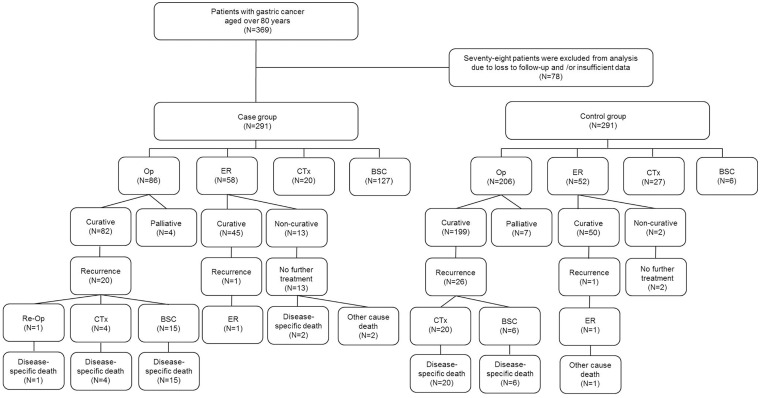
Flow chart of patients included in this study.A total of 291 patients aged over 80 years were included, and another 291 patients aged 80 years or younger were randomly selected as a control group. Op, operation; ER, endoscopic resection; CTx, chemotherapy; BSC, best supportive care.